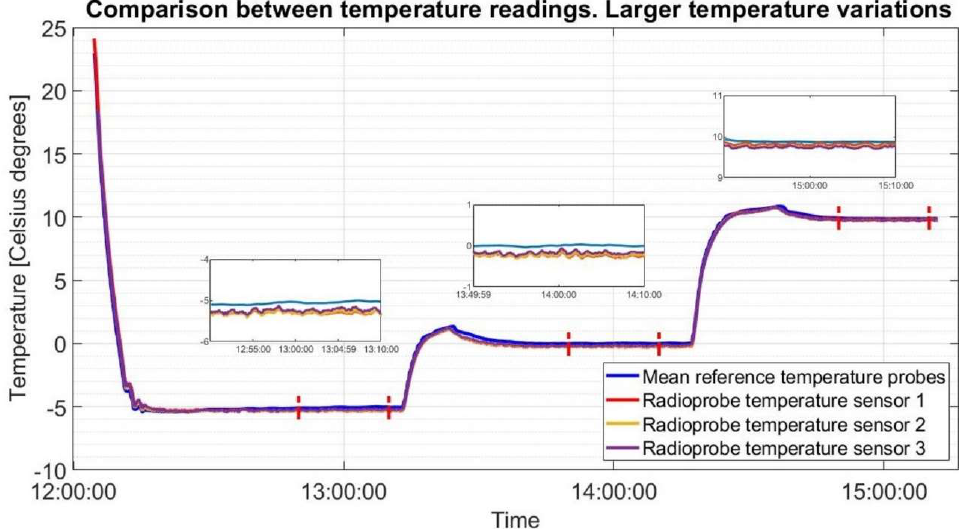
Figure 7. Comparison of temperature measurements between reference temperature sensors and radioprobe sensors. Climatic chamber is set to provide controlled variations in temperature starting from T = +24 °C, RH = 30% until reaching the set points of T = −5 °C, T = 0 °C, and T = 10 °C.